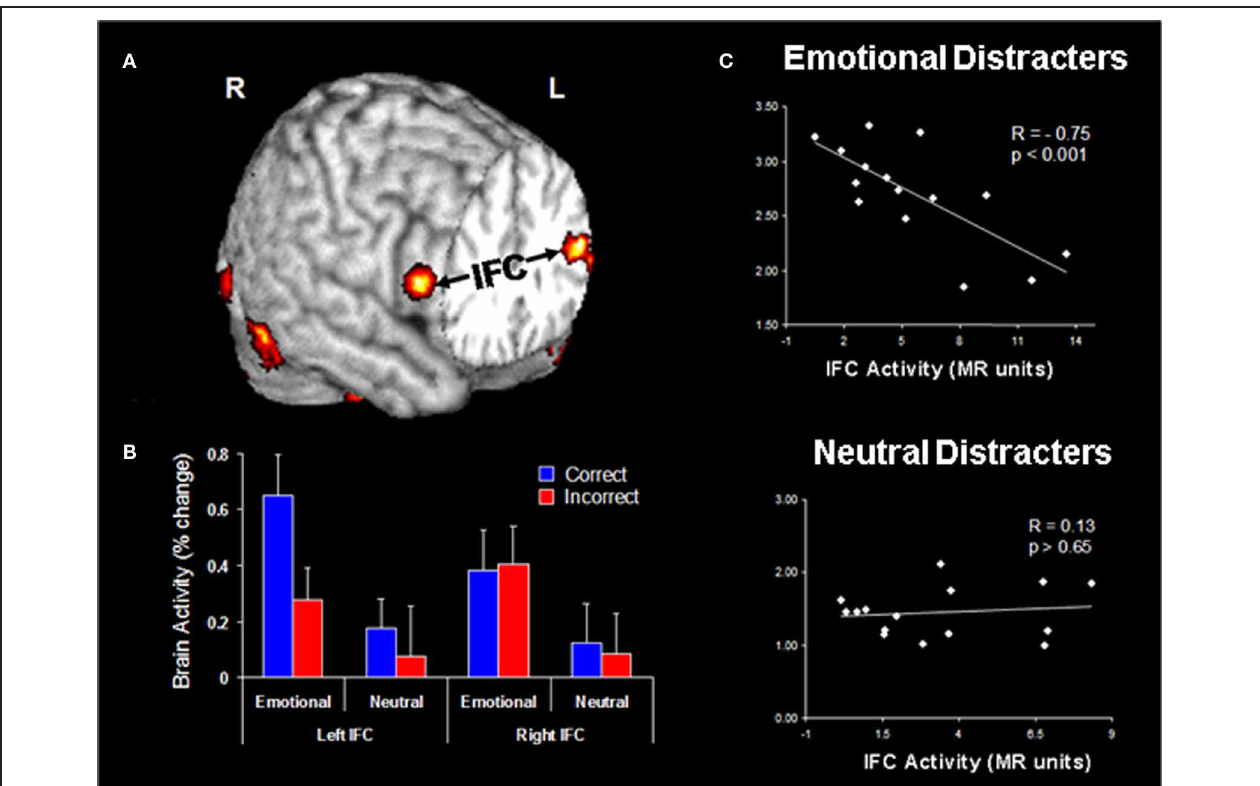
emotional distractibility scores. Taken together, these findings suggest a hemispheric asymmetry in the IFC with respect to its role in actually coping with distraction (left vlPFC/IFC) vs. coping with the subjective feeling of being distracted (right vlPFC/IFC). Correct/Incorrect, Remembered/Forgotten items in the WM task; R, Right; L, Left. Adapted from Dolcos and McCarthy (2006) and Dolcos et al. (2006), with